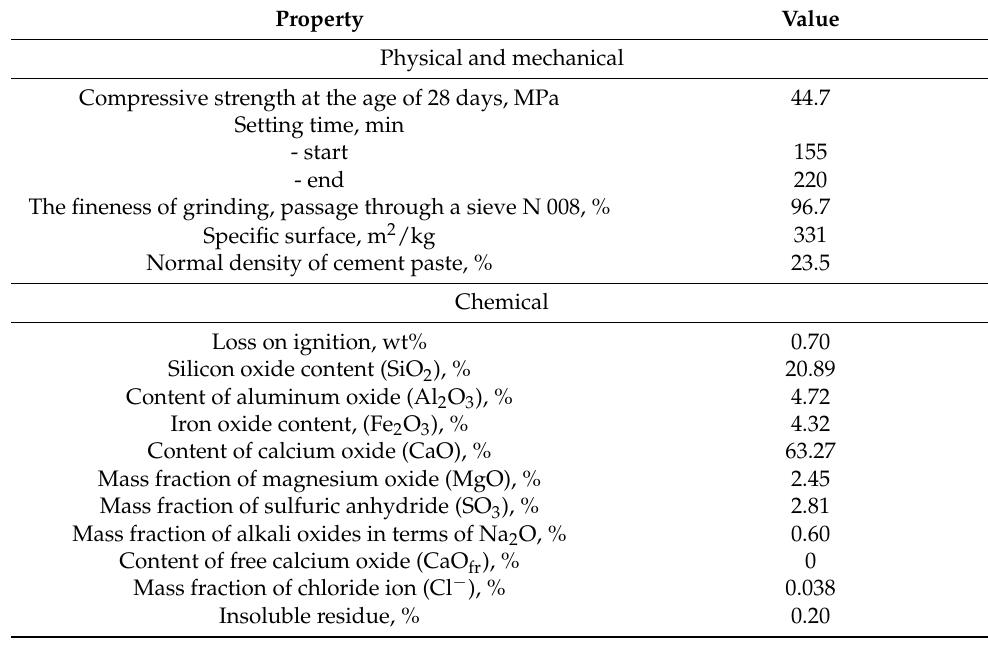
Table 1. Physico-mechanical characteristics and chemical composition of Portland cement CEM I 42.5N. Property Compressive strength at the age of 28 days, MPa